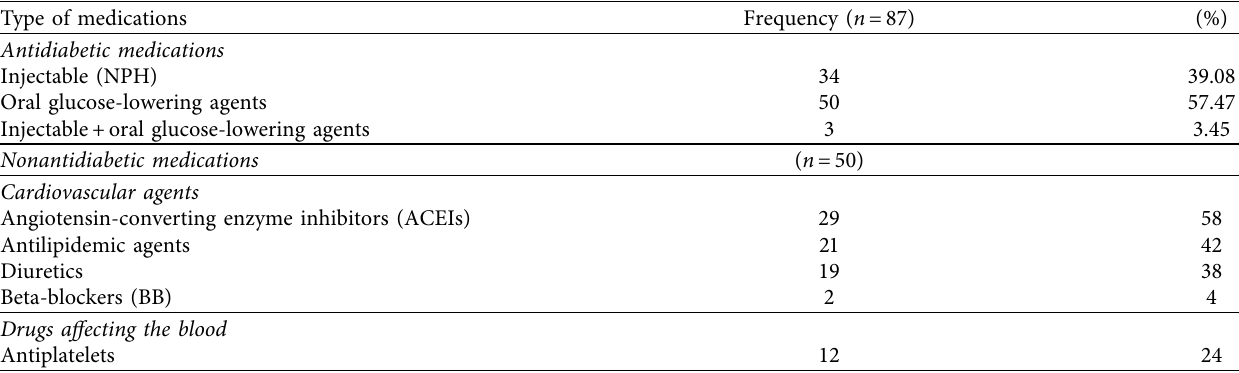
Type of medications